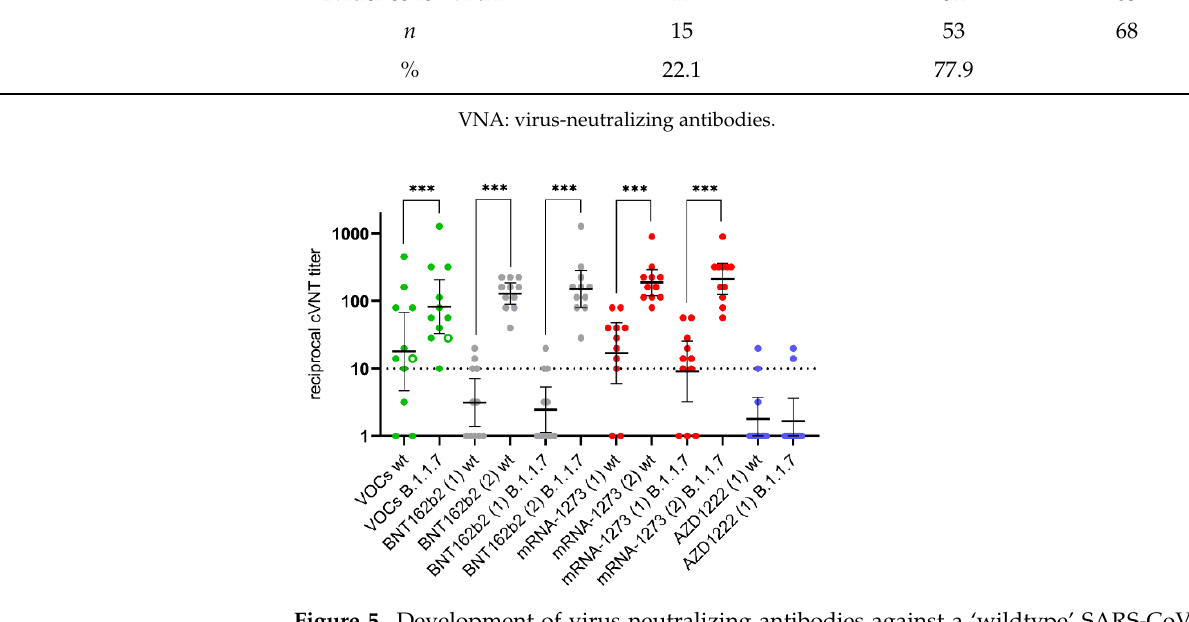
Figure 5. Development of virus neutralizing antibodies against a ‘wildtype’ SARS-CoV-2 strain (wt) and against a B.1.1.7 virus after infection with variants of concern (VOCs: n = 10, B.1.1.7, filled green dot; n = 1, B.1.351, empty green dot) or after first (1) and second (2) vaccination with with messenger ribonucleic (BNT162b2; mRNA-1273) and vector (AZD1222) vaccines ( n = 11 age and gender matched vaccinees per vaccine group). Results were obtained in a laboratory-developed Vero-cell based neutralization assay (cVNT) under BSL-3 conditions. A serum dilution of >1:10 is considered as protective. The reciprocal geometric mean titer and the 95% confidence intervals are given. Stars indicate statistical significance (***: p < 0.001) calculated in a paired, non-parametric test (Wilcoxon test).